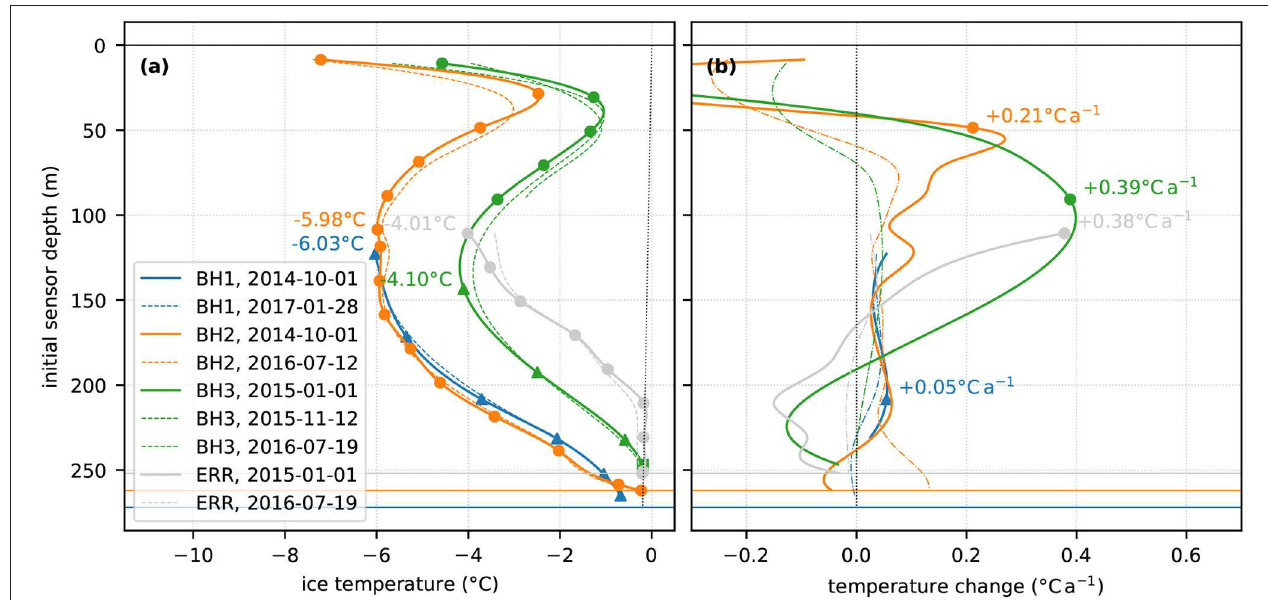
FIGURE 4 | (a) Temperature profiles for selected dates (see Figure 3 ) ca. 2–5 months after the drilling (solid lines) and toward the end of the available record (dashed lines), for the three boreholes (BH1, BH2, and BH3) including BH3 erratic data (ERR, see text). The second profile from BH2 (orange dashed lines) corresponds to manual readings. Other values are daily means from the automated record. Borehole initial basal depths (thin horizontal lines) and minimum observed non-seasonal temperatures are indicated (dates as YYYY-MM-DD). (b) Observed rate of change between the two first profiles (solid lines) and theoretical change due to heat diffusion and viscous dissipation (dash-dotted lines) for the corresponding time period. The maximum observed warming is indicated. All curves were interpolated using cubic